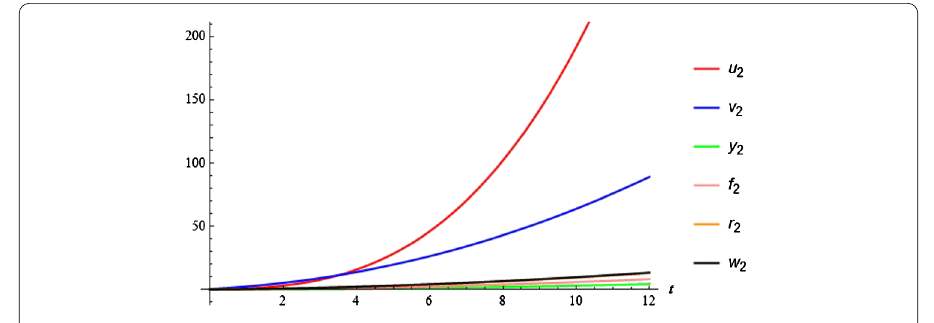
Figure 1 Two-dimensional surfaces of system